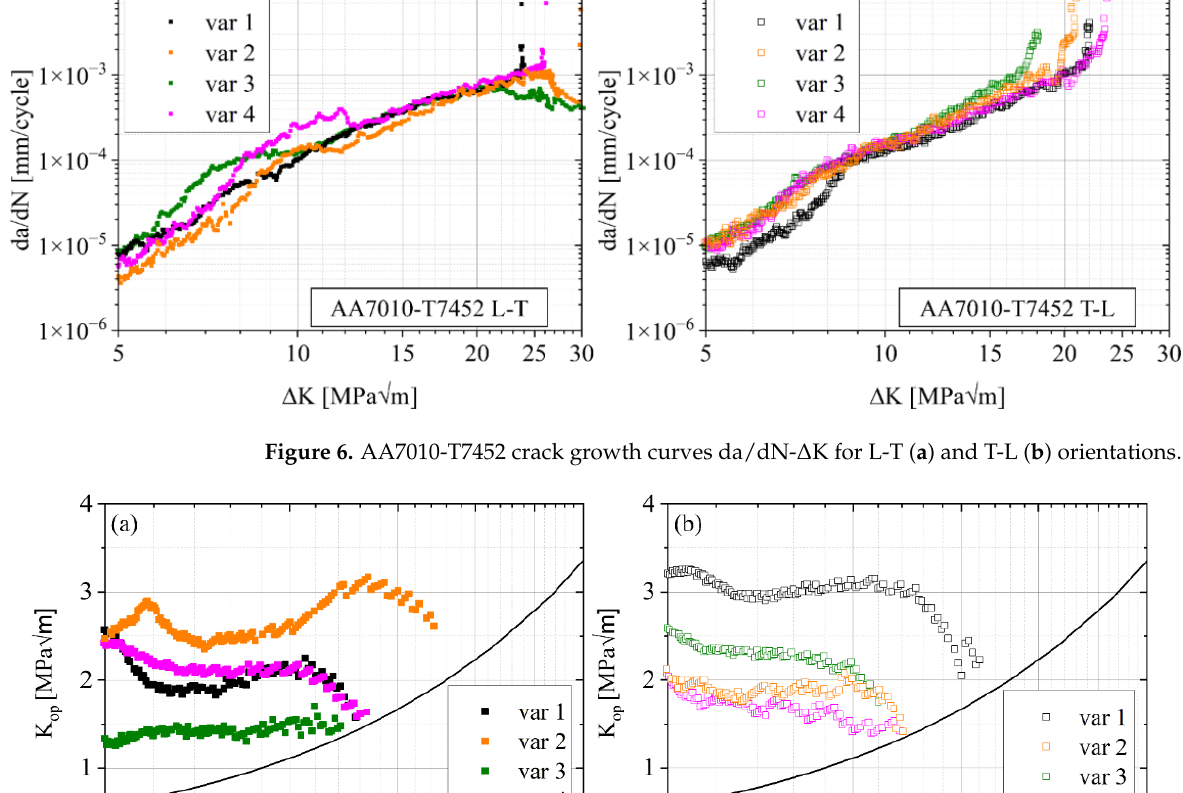
Figure 6. AA7010-T7452 crack growth curves da/dN- Δ K for L-T ( a ) and T-L ( b ) orientations.